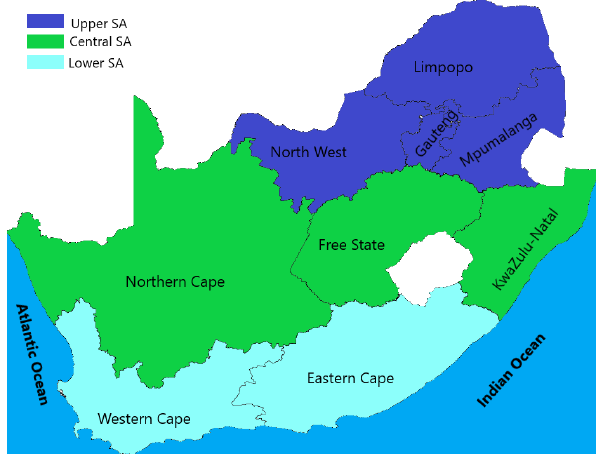
Figure 1. Map of South Africa divided into three sub-regions based on the distributions of aerosol